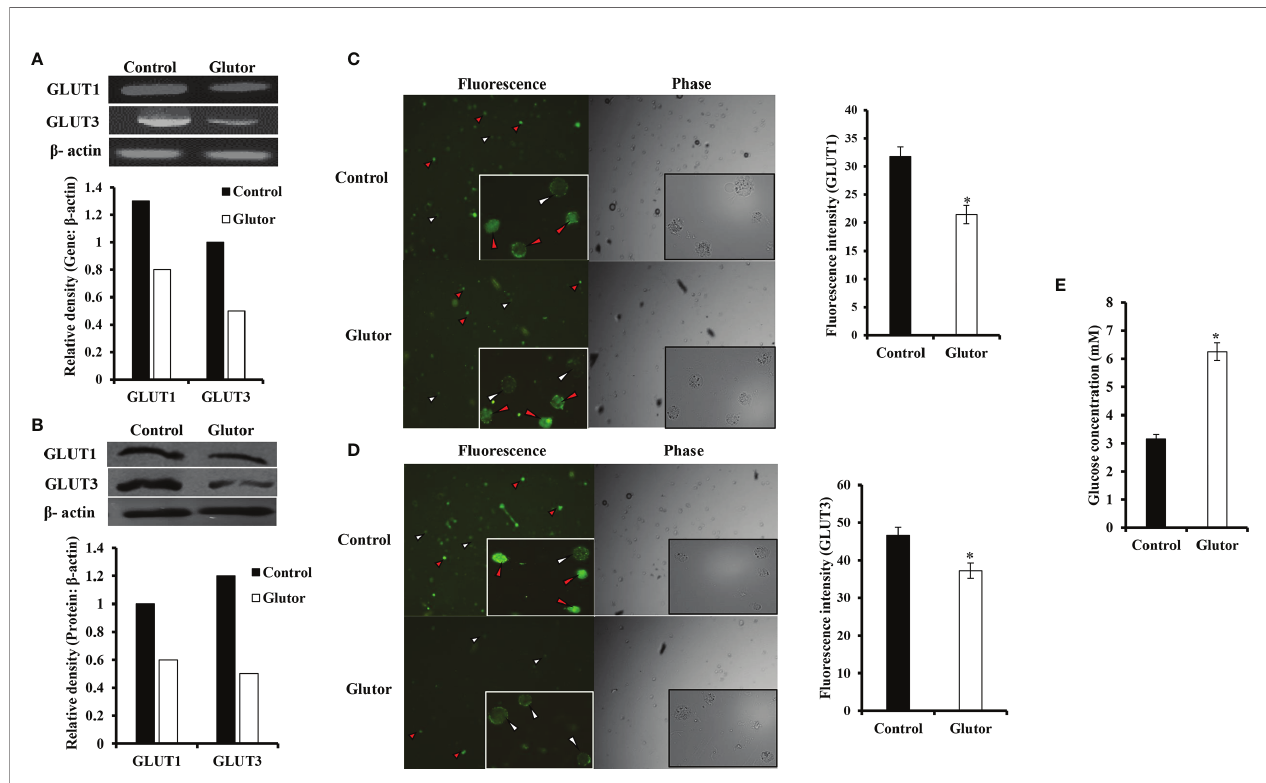
FIGURE 2 | Effect of glutor on the expression of GLUT1, GLUT3, and glucose uptake by DL cells. DL cells (1 × 10 5 ) were incubated in a medium alone or containing glutor (0.01 µM) for 24 h, followed by evaluation of GLUT1 and GLUT3 expression by RT-PCR (A) and Western blotting (B) as described in the Materials and Methods section. The expression of GLUT 1 and GLUT 3 was also examined by immuno fl uorescence (C, D) . The glucose level in the culture supernatant of control and glutor-treated DL cells was measured (E) as described in the Materials and Methods section. Values shown in (E) are mean ± SD. The plates shown in (A – D) are from a representative experiment out of at least two experiments with similar results. Accompanying bar diagrams are densitometric images of the respective bands. Bar diagrams accompanying the fl uorescence images depict fl uorescence intensity. * p < 0.05 vs. respective